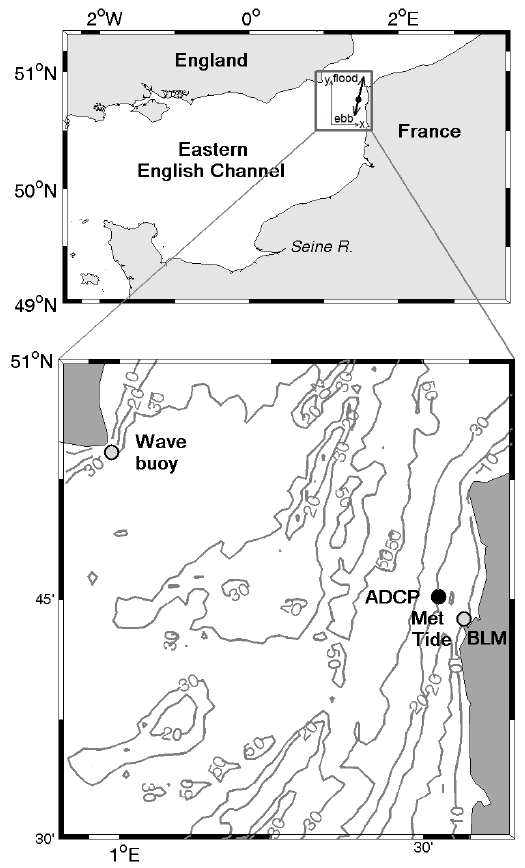
Fig. 1. The eastern English Channel (upper panel) and location of the ADCP deployment site (black circle) in the Strait of Dover (lower panel). Grey circles denote location of the CEFAS wave buoy, Boulogne-sur-Mer lighthouse and tidal gauge (BLM). The bottom topography is also shown. The x-y plane and direction of ebb and flood flows are shown in the upper panel.